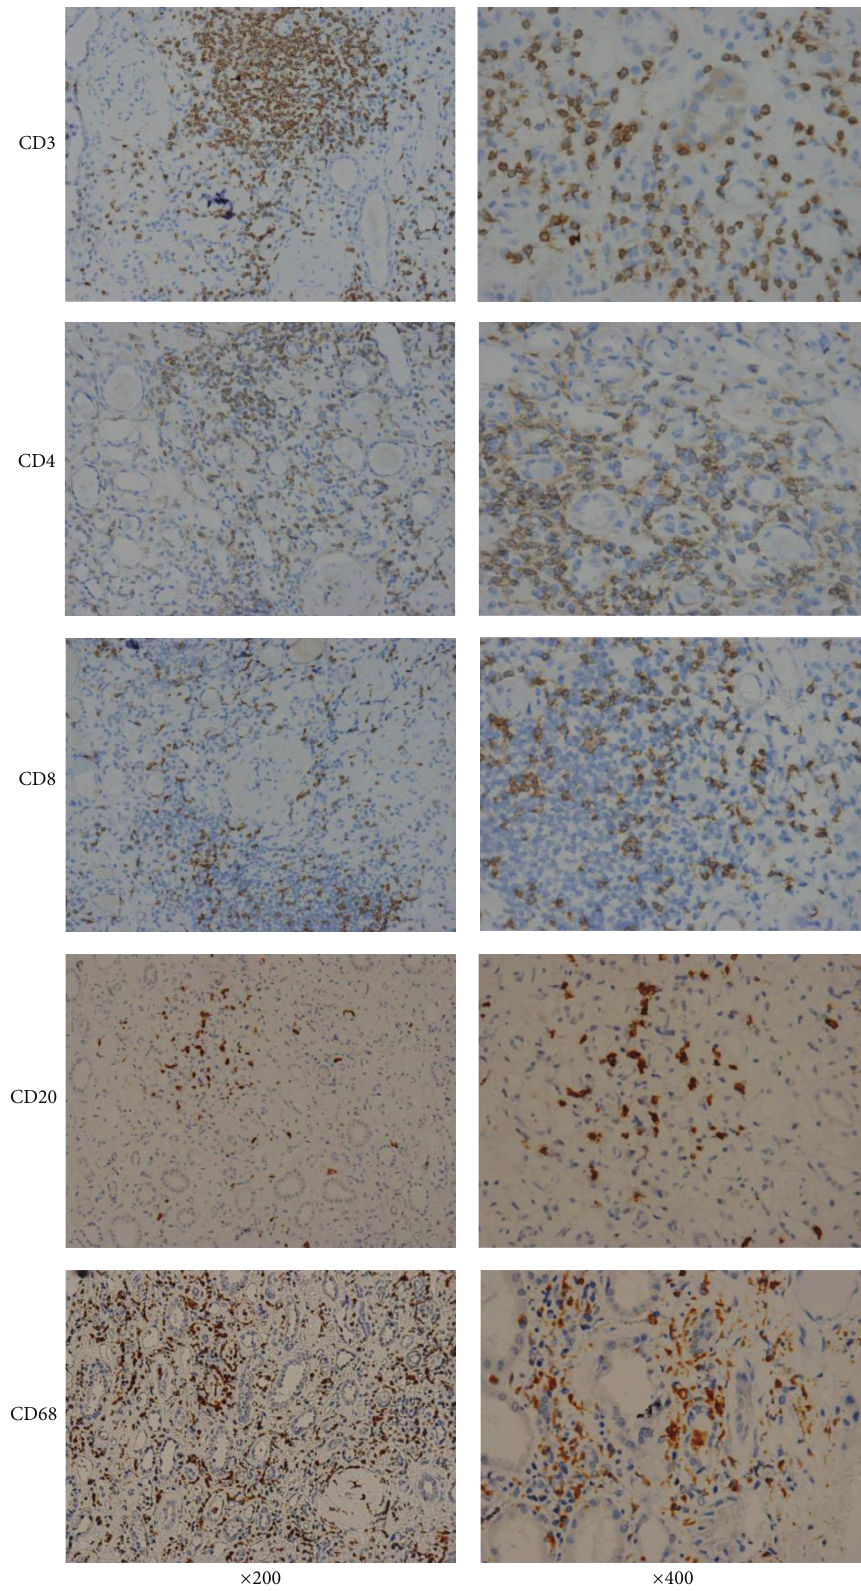
Figure 2: Immunohistochemical characterization of the inflammatory infiltrate in BK virus allograft